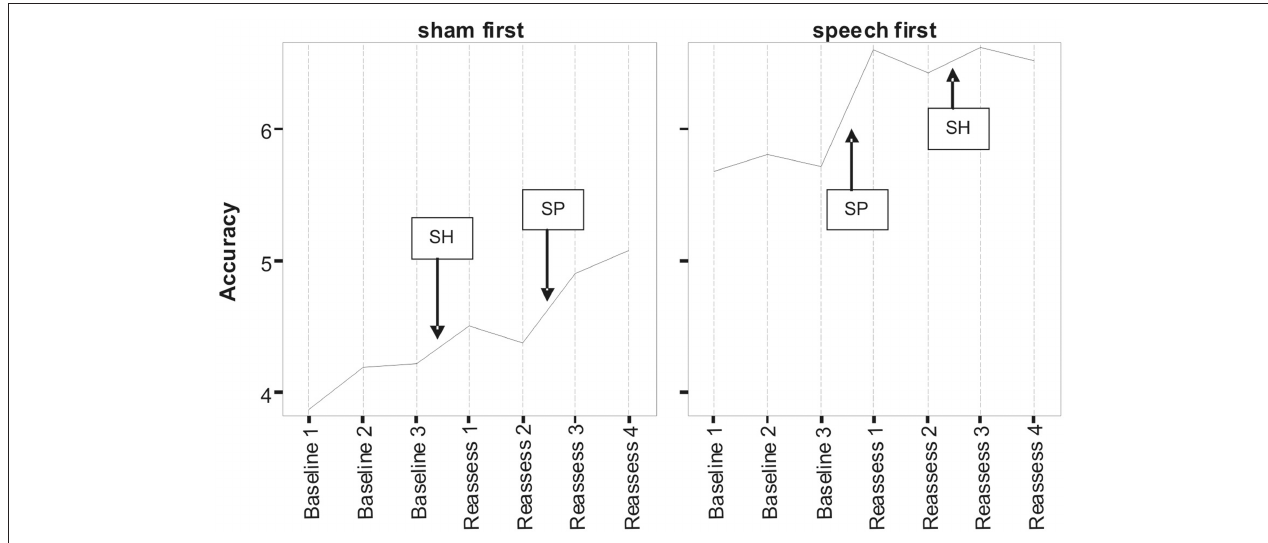
FiguRE 1 | Lexical accuracy scores as a function of speech treatment (SP) and sham treatment (SH) for the two phase conditions defined as Sham First and Speech First. Data are for treated items. The full scale of accuracy scores ranges 0–7 (see Pilot Data for additional